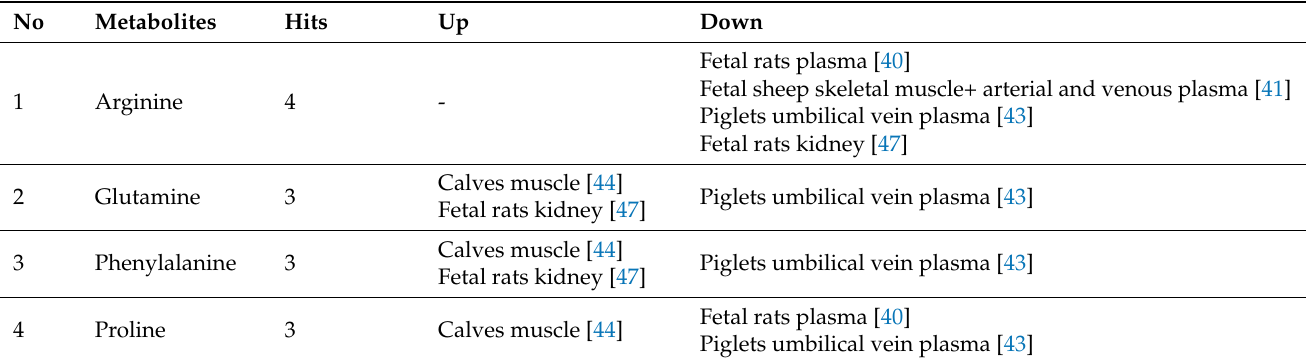
Table 6. High Frequency Metabolic Biomarkers of Animal